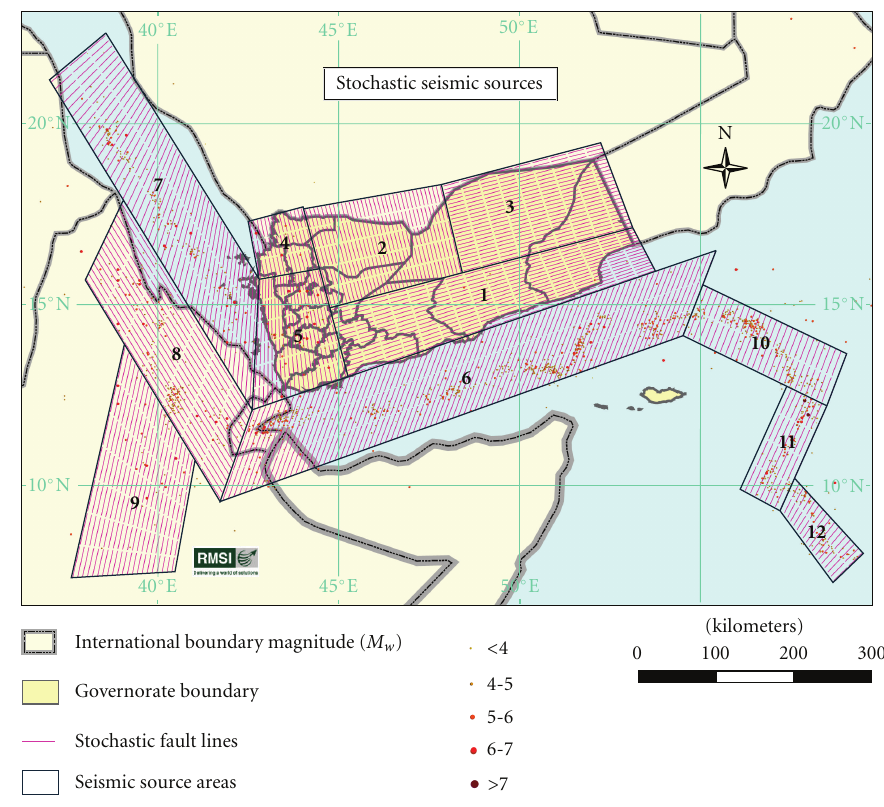
Figure 7: Delineated seismic sources (area seismic sources converted into fault lines for generation of stochastic events). Source details are provided in Table 2.